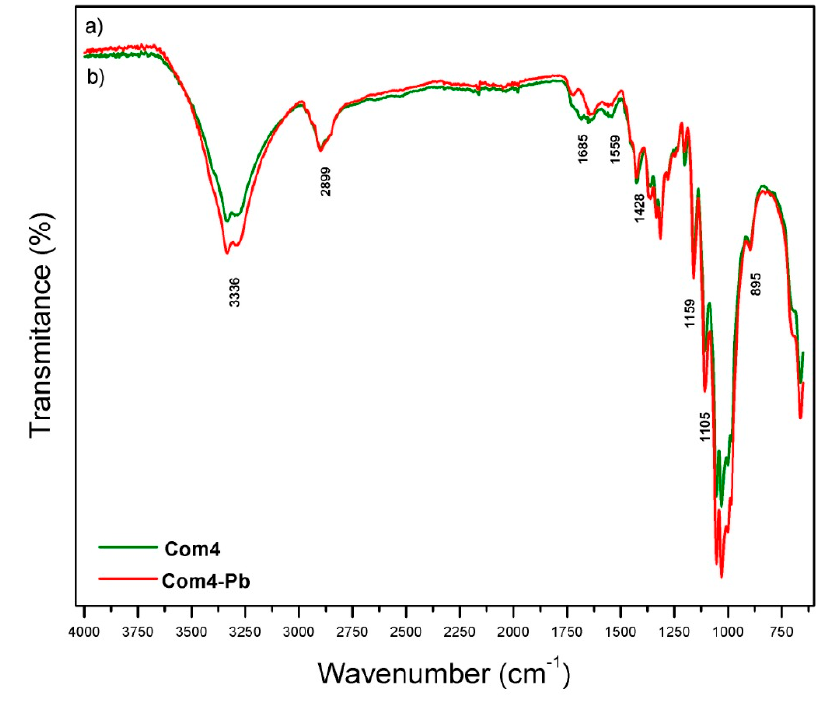
Figure 3. FTIR spectra of composite Com-4 (a) before adsorption and (b) after Pb(II) adsorption.